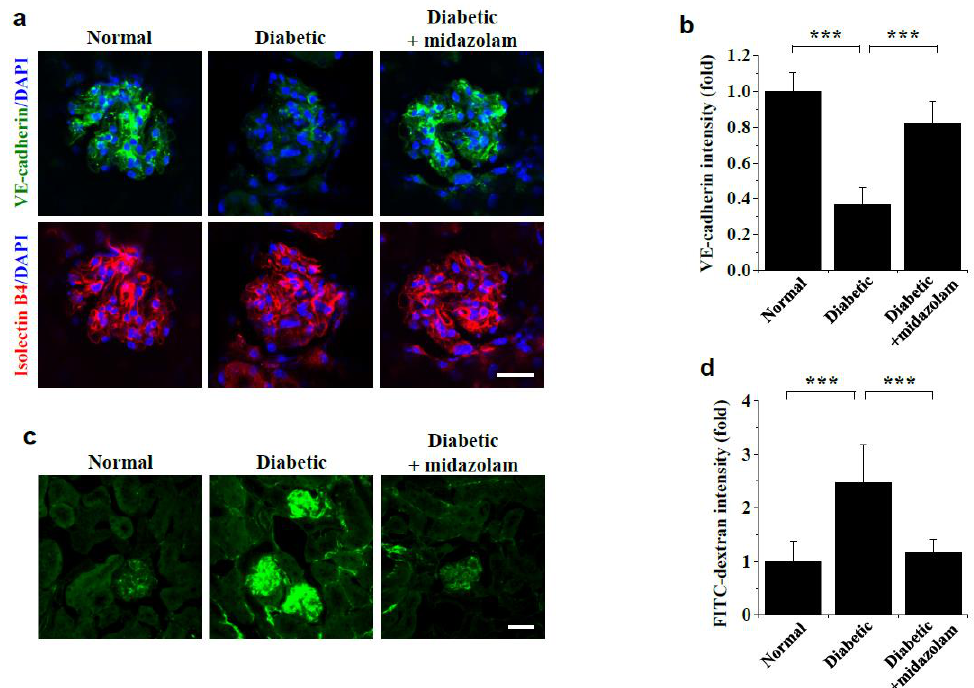
Figure 2. Midazolam treatment inhibits hyperglycemia-induced VE-cadherin disruption and microvascular leakage in kidneys of diabetic mice. Diabetic mice were treated with midazolam via subcutaneous injection for 6 weeks, and VE-cadherin ( a , b ) and microvascular leakage ( c , d ) were visualized and analyzed by confocal microscopy in the kidneys of normal, diabetic, and midazolam-treated diabetic mice ( n = 8). ( a ): Representative fluorescence images of VE-cadherin staining, with 4 (cid:48) ,6-diamidino-2-phenylindole (DAPI) nuclear counterstaining (blue), in kidney glomeruli. Scale bar, 25 µ m. ( b ): Adherens junctions were quantified by measuring fluorescence intensities of VE-cadherin in the renal glomerulus. ( c ): Representative fluorescence images of fluorescein isothiocyanate (FITC)-dextran extravasation in kidney glomeruli. Scale bar, 50 µ m. ( d ): Microvascular leakage was quantified by measuring fluorescence intensities of FITC-dextran in the renal glomerulus. *** p <